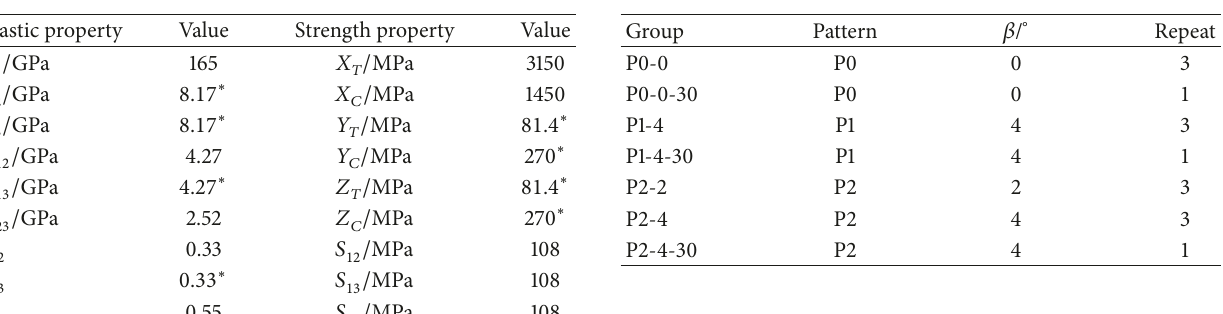
Table 1: Mechanical properties of IMS194/CYCOM977-2.